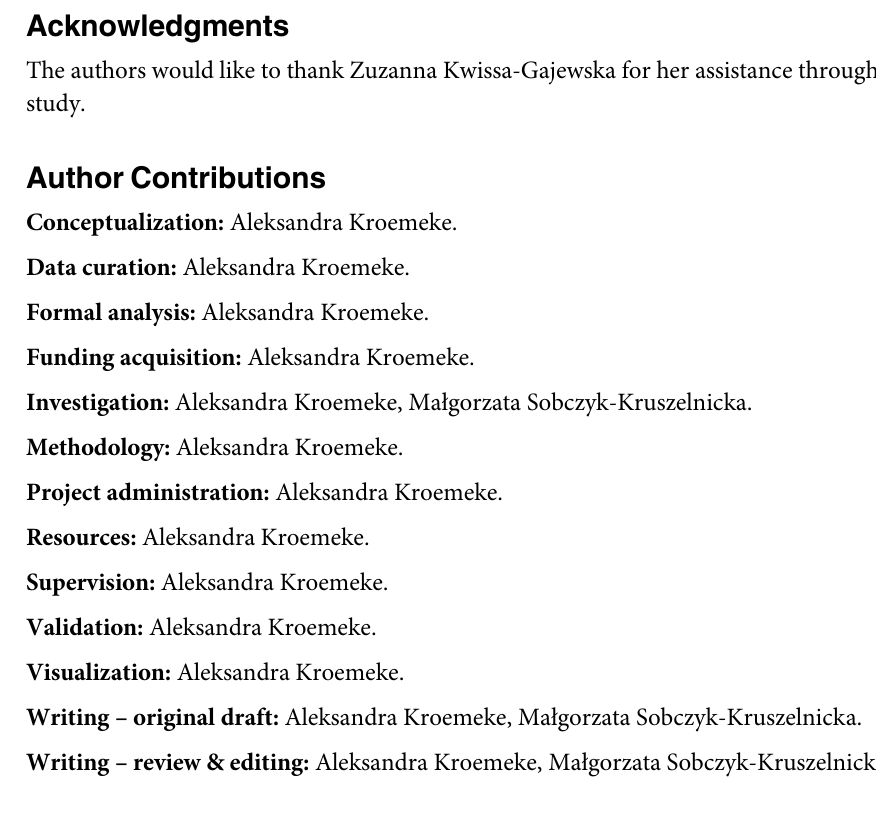
S1 Table. Results of between-dyad level effects [Estimate (Est.) and Standard Error (SE)] of coping self-efficacy (CSE), received support (RS), and their interaction on affect in 200 patient-caregiver dyads (in the same- and next-day analyses). Legend: PA, positive affect, NA, negative affect. � p < .05; �� p < .01; ��� p < .001.